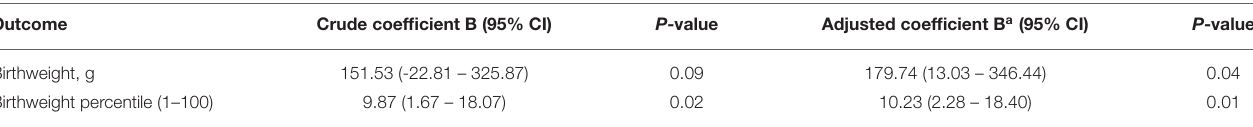
TABLE 5 | Neonatal outcome (crude and adjusted coefficient B) for singleton birth after frozen-thawed embryo transfer in the absence ( n = 114) or presence ( n = 68) of a corpus luteum.